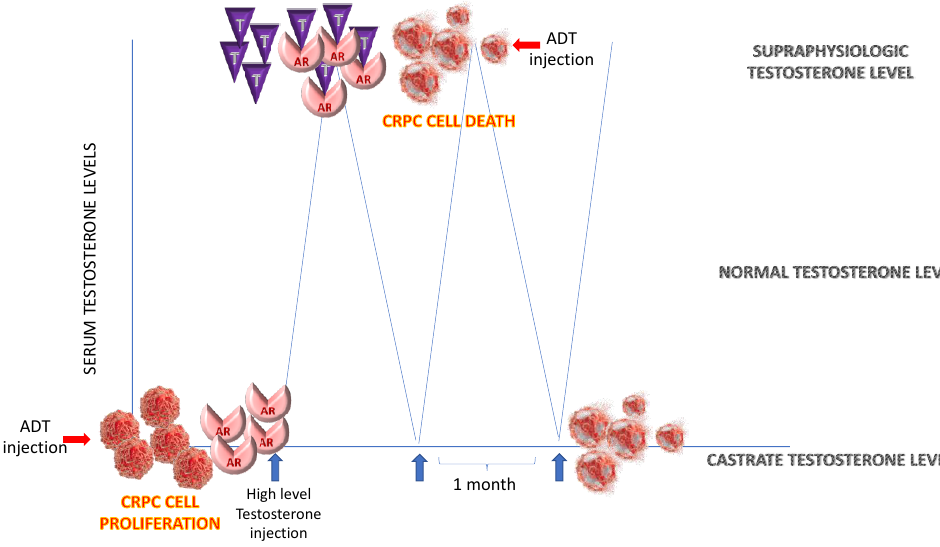
Figure 4. Antitumor mechanism of intermittent administration of high-dose androgens in CRPC cells. Development of castrate-resistant tumor cells involves acquisition of adaptive auto-regulation giving place to an increase in AR expression in a low androgen environment. This increase inhibits apoptotic death and stimulate cancer cell proliferation. AR is needed for DNA replication in CRPC cells. When these cells are acutely exposed to supraphysiologic androgen, AR is saturated. This induces a paradoxical cancer cell death via over-stabilizing AR, preventing full relicensing in the next cell cycle.